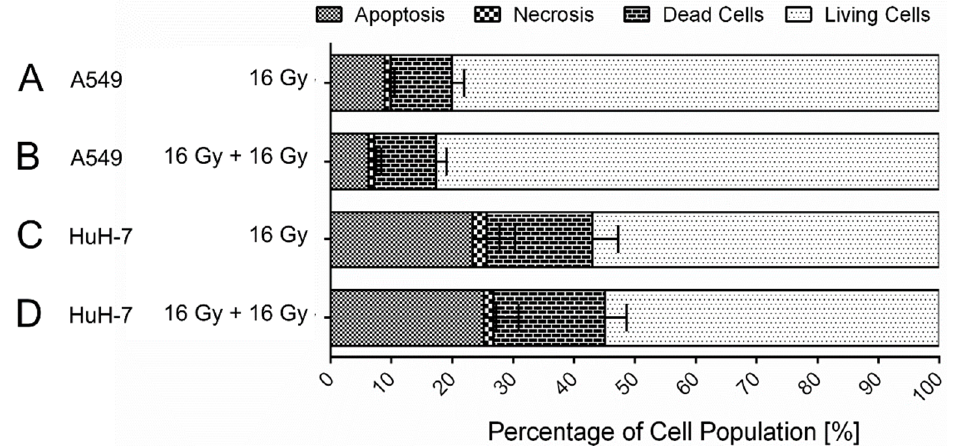
Figure 9. Percentage of apoptotic, necrotic, dead, and living cells of A549 ( A , B ) and HuH-7 ( C , D ) cells after one ( A , C ) and two ( B , D ) treatments with 16 Gy gamma-irradiation each. A second 16 Gy-treatment six days after the first irradiation treatment did not increase the dying cell (apoptotic, necrotic, and dead cells) fraction significantly in both studied cell lines. Shown are mean values ± SD, unpaired, two-tailed t-test, comparison between cells treated with 1 × 16 Gy and 2 × 16 Gy of the respective cell line, N ≥ 3.